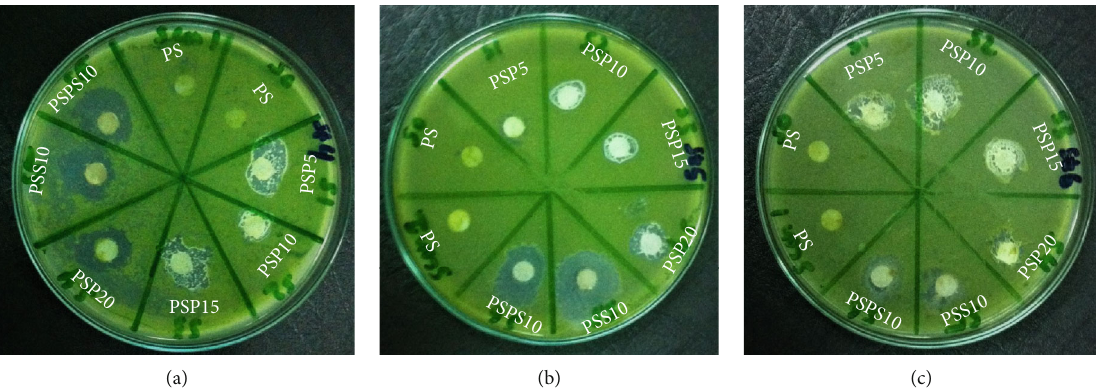
Figure 6: Microalgae-cultured plates with the disk di ff usion method against (a) Dictyosphaerium sp., strain HM1 (DHM1), (b) Dictyosphaerium sp., strain HM2 (DHM2), and (c) Pectinodesmus sp., strain HM3